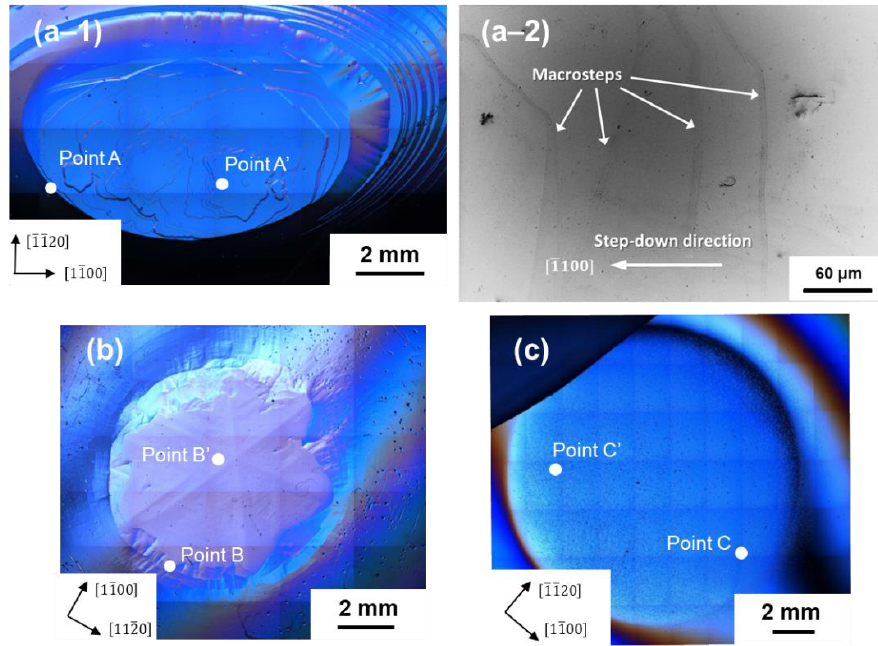
Figure 1. DICM images of the (0001) facet of two-inch diameter ( a–1 ) nominally undoped (boule A, N concentration: mid-10 17 cm − 3 ), ( b ) conventionally nitrogen-doped (sample B, N concentration: mid-10 18 cm − 3 ), and ( c ) heavily nitrogen-doped 4H-SiC boules (sample C, N concentration: mid-10 19 cm − 3 ). AFM observations were conducted at Points A, B, C, A’, B’, and C’, as shown in the images. The former three points were located near the edge of the (0001 ) facet, whereas the latter were located near spiral growth centers on the facet. ( a–2 ) LVSEM image of macrosteps observed on the facet of boule A.